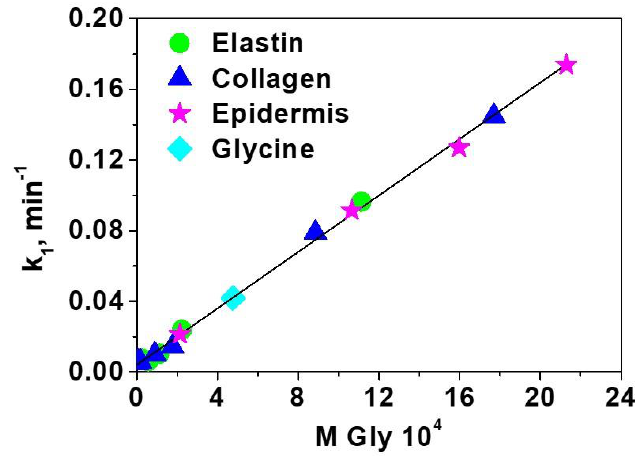
Figure 4. Kinetic rate constants of the kinetic of displacement of the dye by amino acids in the solid sensory F (3)-Cu-D . The rate constants were calculated using the UV / Vis absorption data obtained from the solution where the sensory discs were immersed.